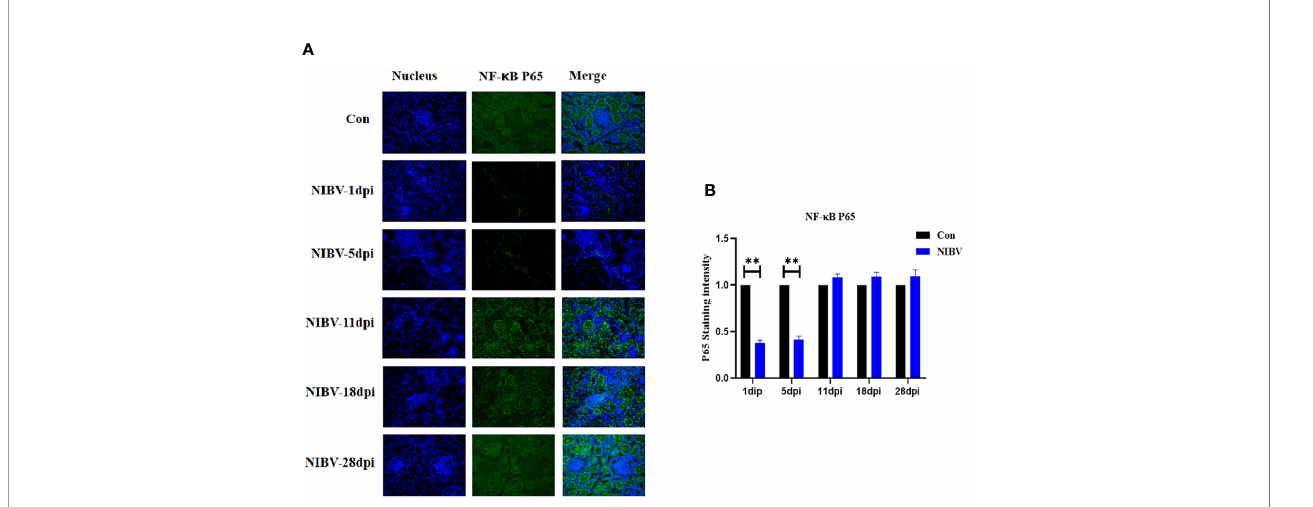
FIGURE 5 | Qualitative and quantitative immuno fl uorescence analysis of NF- k B P65 proteins. (A) In this image, the nucleus staining is shown in blue, the NF-vB P65 stained is shown in green, and the combined images show the co-localization signal (400 total magni fi cation). (B) Mean NF- k B P65 staining intensity in each group. Data are expressed as the mean SD, *(0.01 < P < 0.05), **(P < 0.01), (N=3).